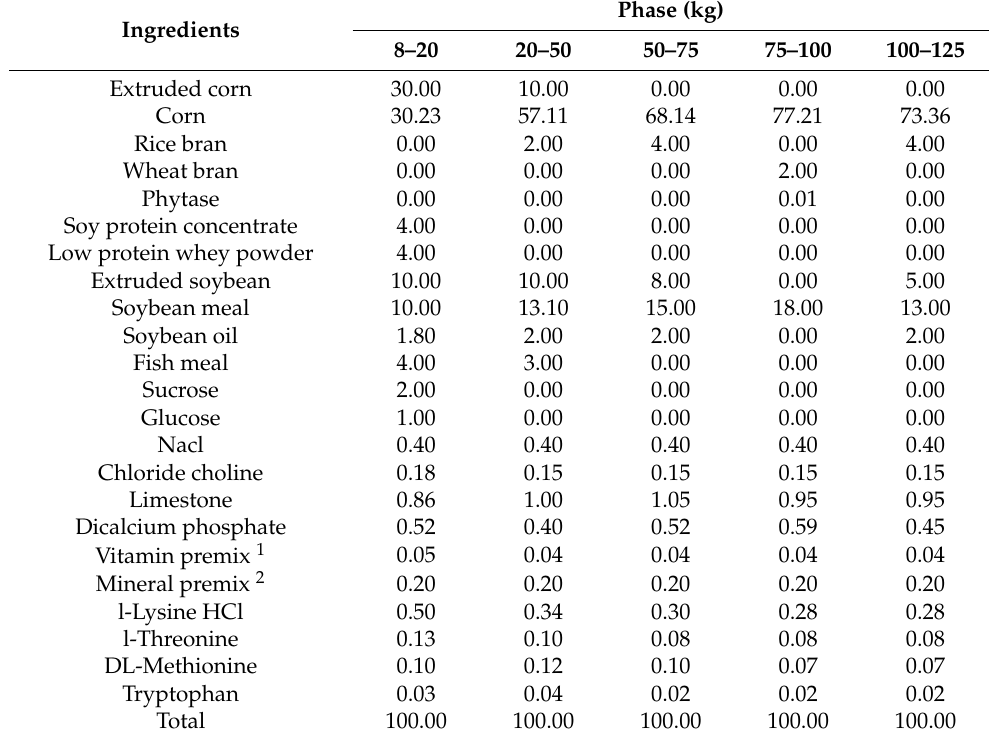
Table 1. Composition and nutrient levels of basal diet (on an as-fed